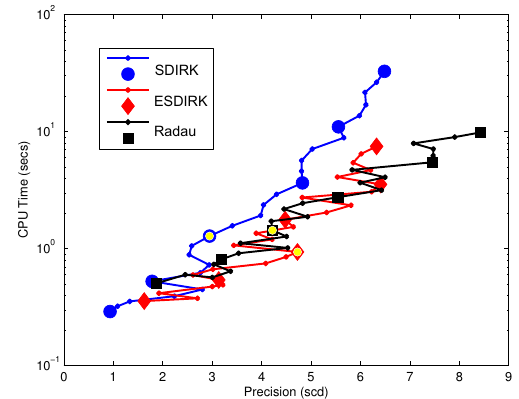
Fig. 10: AMPAR work-precision diagram with solver run time vs. scd for each IRK method. Integer exponential tolerances, i.e. 10 − 4 , 10 − 5 , ..., are presented with enlarged symbols. The symbol for rtol = 10 − 6 is distinguished by the yellow circle.